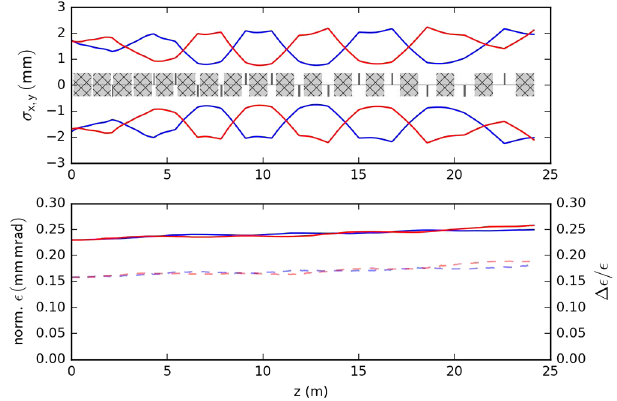
FIG. 4. rms beam envelope for the first pass using 6D waterbag initial distribution with 20 mA bunch current. Radio-frequency cavities are represented by “ x ” patterned boxes, and the F = D quadrupoles are represented by up/down rods. The blue/red curves corresponds to horizontal/vertical. The dashed curve represents Δ ϵ = ϵ .